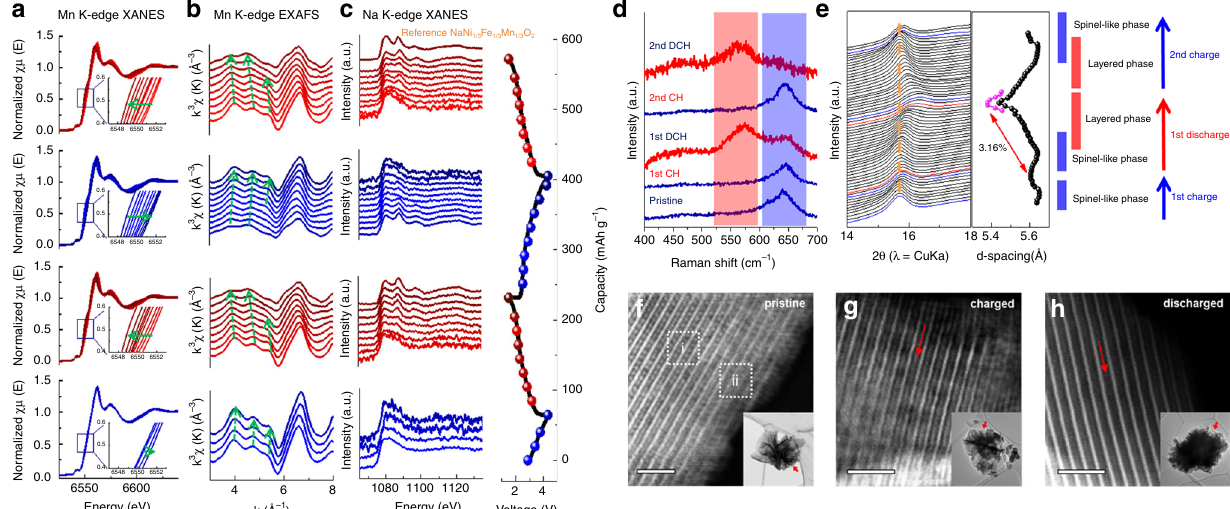
Fig. 3 Reversible structural changes of partially dehydrated Na-bir during the cycling. a Ex situ Mn K-edge XANES spectra, b Ex situ k 3 -weighted Mn K-edge EXAFS spectra of partially dehydrated Na-bir during the initial two cycles. c Ex situ Na K-edge XANES spectra of partially dehydrated Na-bir during the initial 2 cycles. d Ex situ Raman spectra of partially dehydrated Na-bir in the pristine, 1st charge, 1st discharge, 2nd charge, and 2nd discharge state. e In situ XRD patterns of partially dehydrated Na-bir during Na ion insertion/extraction at a current density of 30 mA g − 1 . High-resolution ADF-STEM images of f pristine, g charged, and h discharged partially dehydrated Na-bir. The scale bars are 2 nm